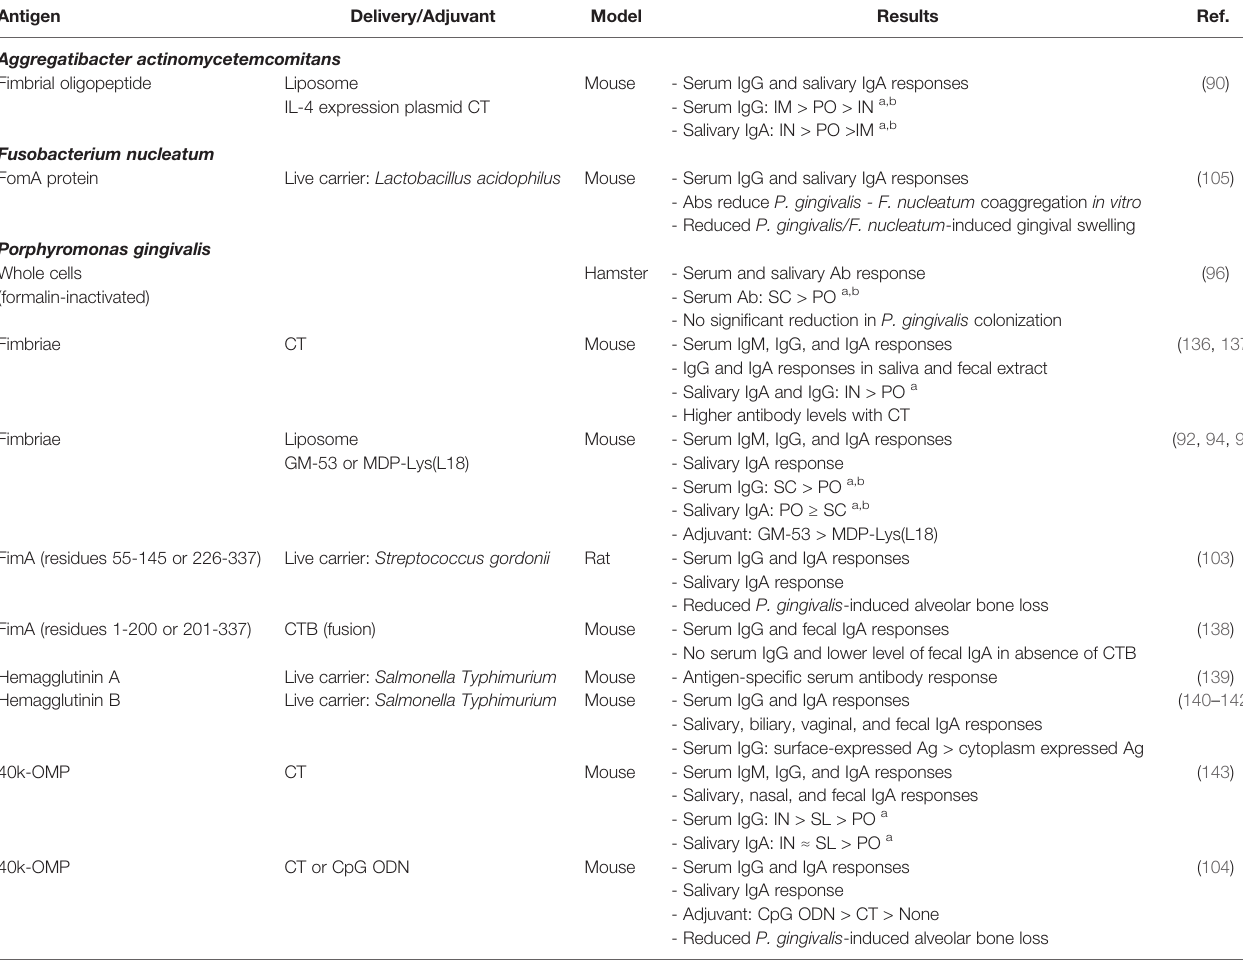
TABLE 1 | Preclinical development of oral vaccines against periodontal disease, organized per target pathogen.